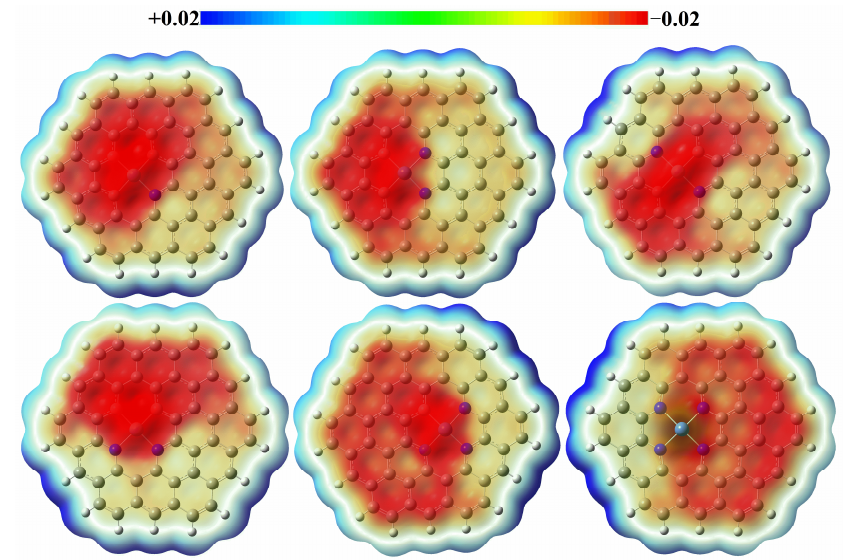
Figure 2. The molecular electrostatic potential of graphene-NiN 1 , graphene-NiN 2 (A), graphene- NiN 2 (B), graphene-NiN 2 (C), graphene-NiN 3 and graphene-NiN 4 (electron density: 0.001 a.u.).